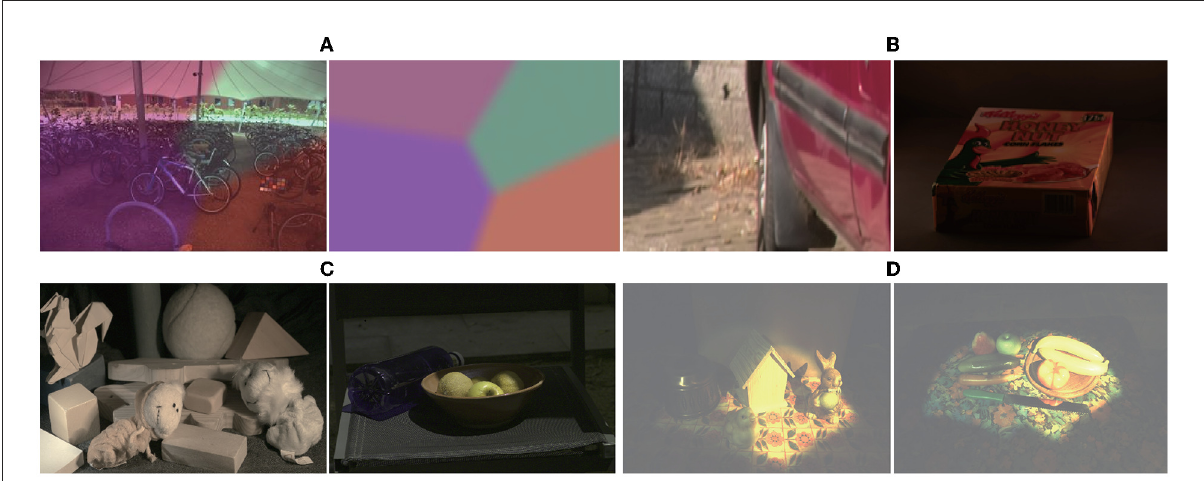
FIGURE2 Images under multiple illuminations. From left to right: (A) Synthetic images; (B) Images from Gijsenij dataset: http://www.colorconstancy.com/ wp-content/uploads/2014/10/multiple_light_sources_dataset.zip Reproduced with permission from Arjan et al. (2012); (C) Images from MIMO dataset available at: http://www5.cs.fau.de/research/data/two-illuminant-dataset-with-computed-ground-truth/. Reproduced with persmission from Beigpour et al. (2014); (D) Images from Bleier dataset available at: http://www5.cs.fau.de/research/data/multi-illuminant- dataset/index.html. Reproduced with permission from Bleier et al.